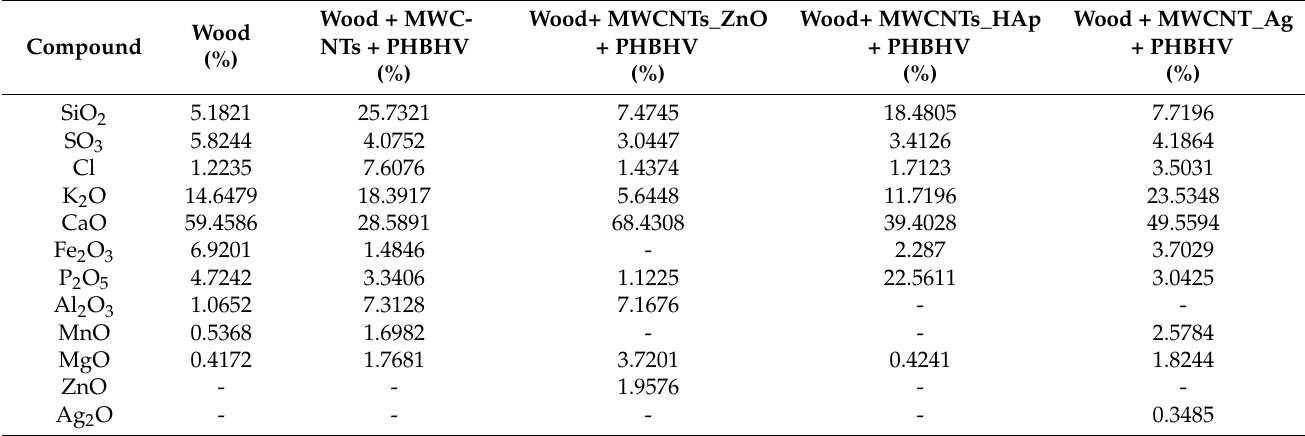
Table 2. Composition of untreated and untreated samples investigated by